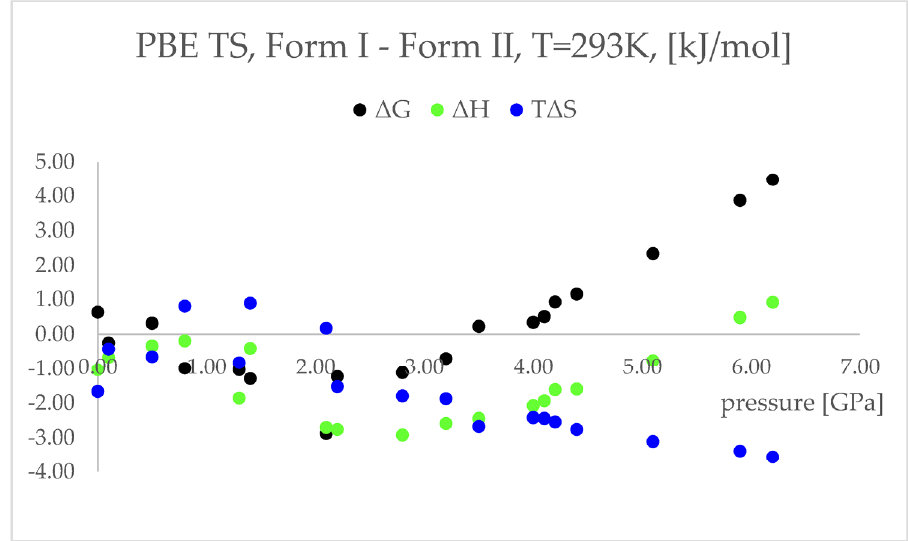
Figure 6. Differences between the thermodynamic parameters: free energy ( ∆ G, black dots) enthalpy ( ∆ H, green dots), temperature times entropy (T ∆ S, blue dots); Form I—Form II; of the structures modelled using PBE TS functional at 293 K, with respect to